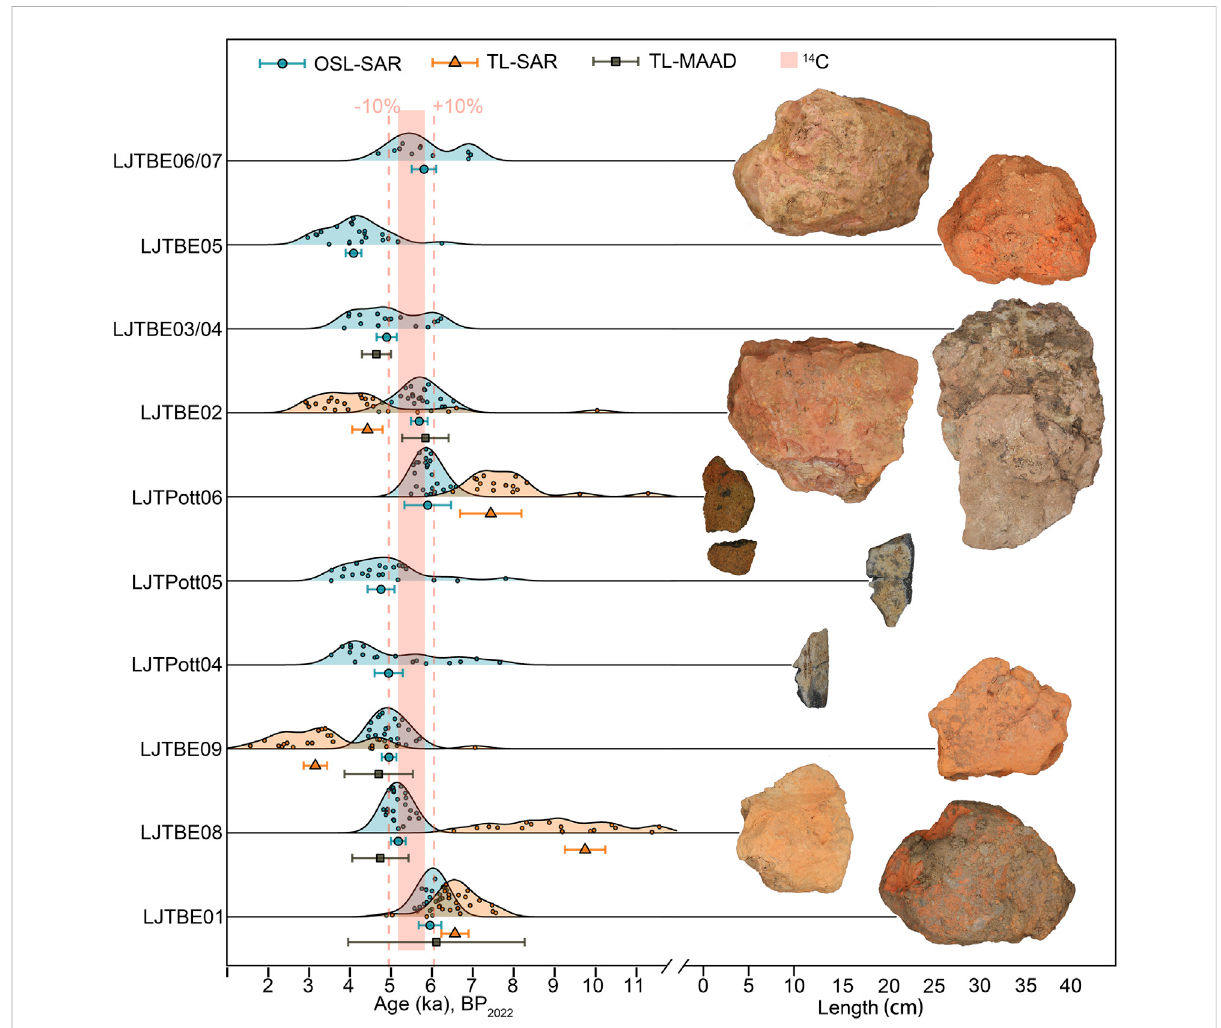
FIGURE 8 ComparisonofOSL-SAR,TL-SAR,TL-MAADand 14 Cdatingmethods.Thelightblue fi lledcolorrepresentsthekerneldensityestimate(KDE)plot of OSL-SAR, and the light brown fi lled color represents that of TL-SAR. The green solid circles represent the OSL-SAR ages, the red solid triangles representtheTL-SARages,thedarkbluesolidsquaresrepresenttheTL-MAADages,andthepinkbandrepresentstherangeofthetwocorrected 14 C ages. The red dotted lines indicate the range of ±10% mean 14 C ages for four samples (two are measured in this study, and the others are cited from previous